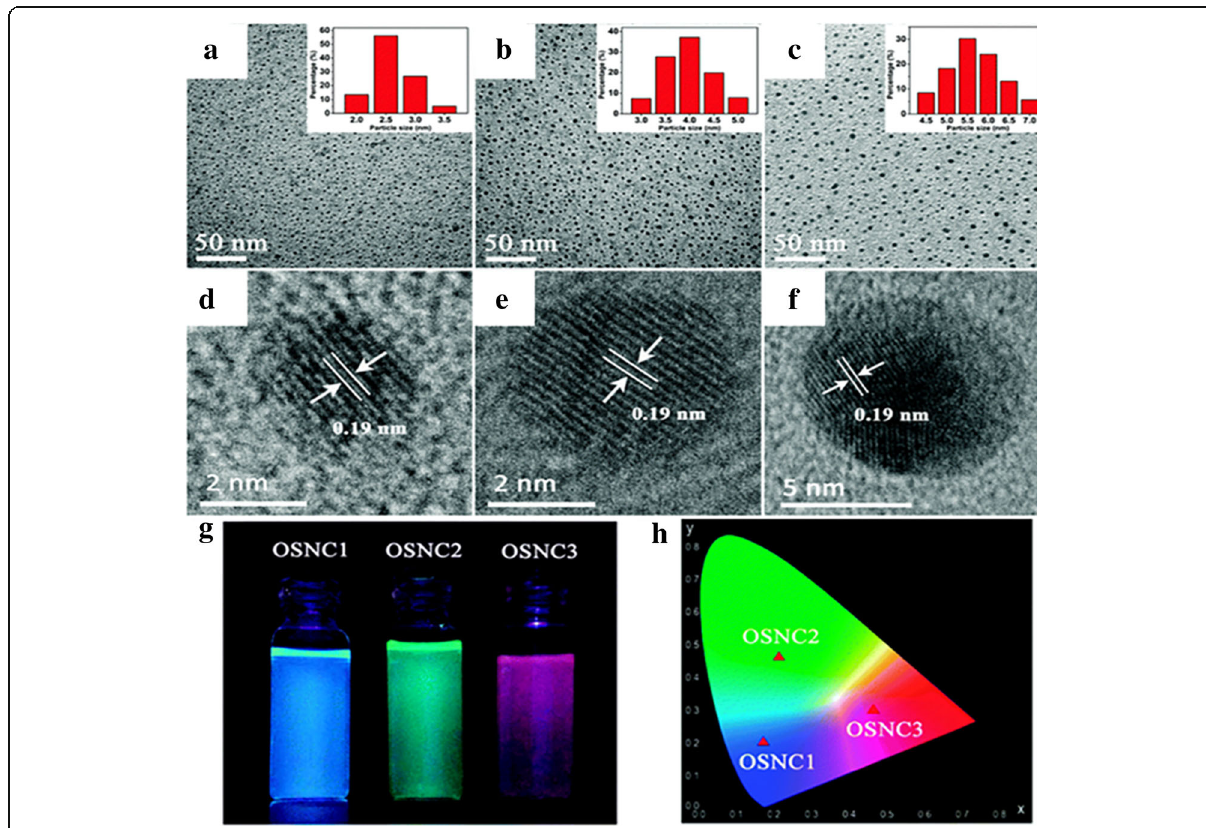
Fig. 12 Characterizations of OSNCs: a – c as TEM images and d – f as high resolution transmission electron microscopy (HRTEM) images. g The photographs of OSNC samples subject to UV-light illumination. h The distribution on the Commission Internationale de l ’ Eclairage (CIE) chromaticity diagram